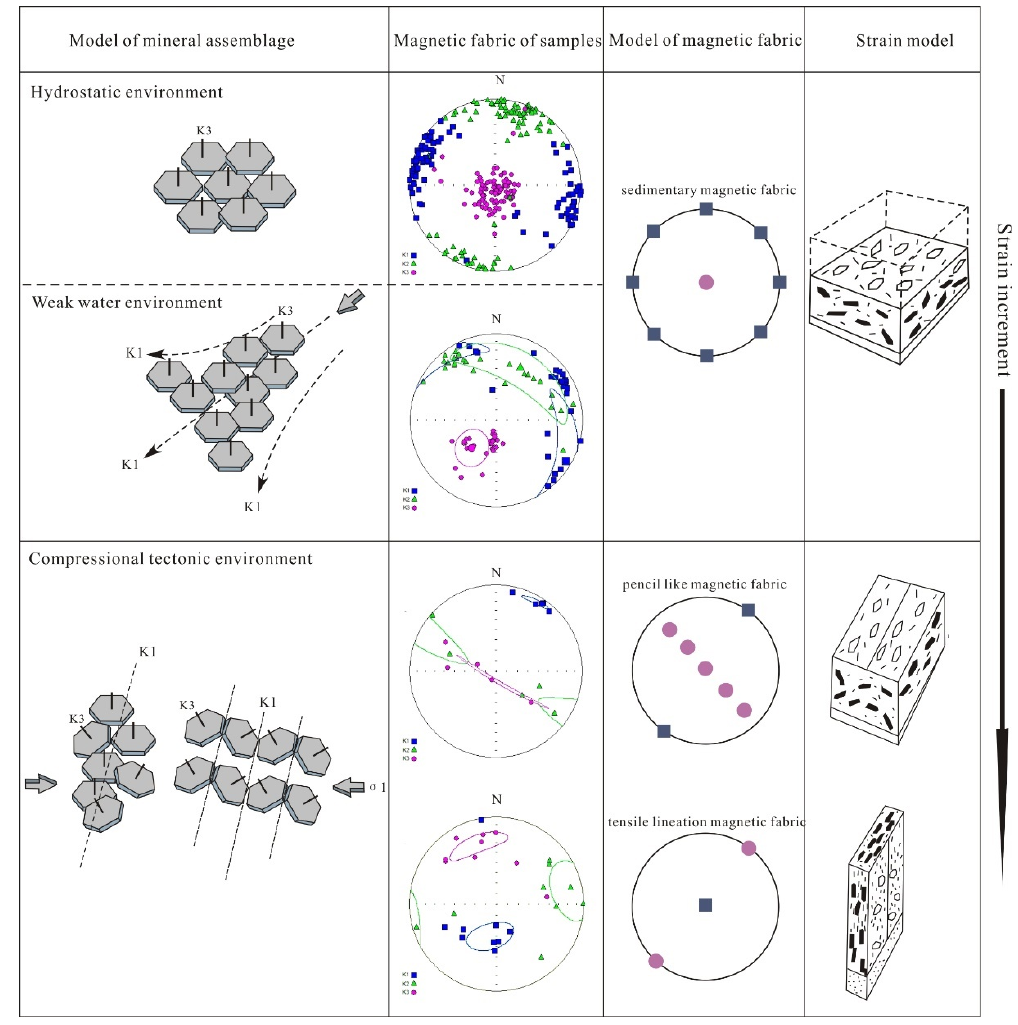
Figure 10. Different features of magnetic fabrics and corresponding modes of formation.